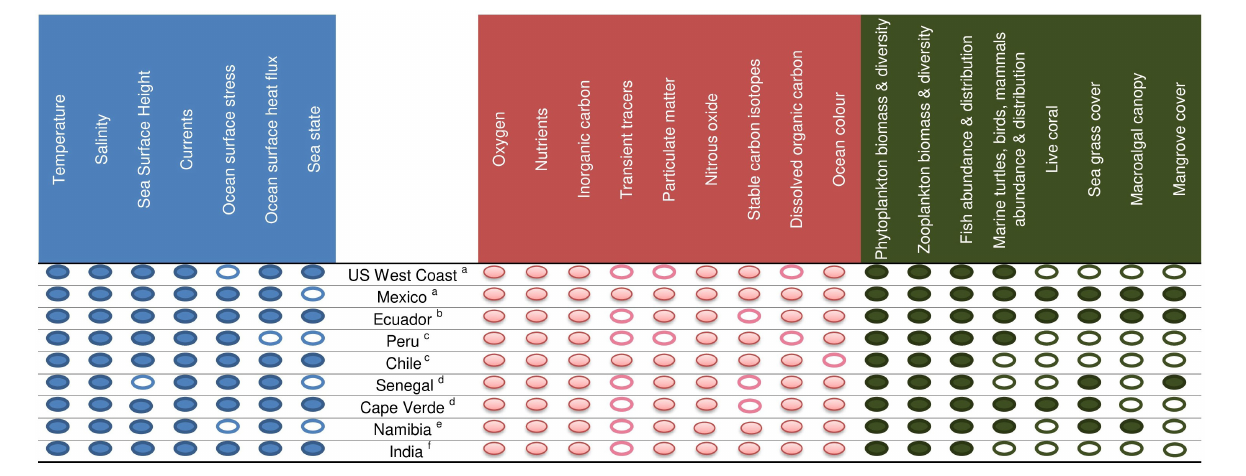
in national scientific journals. Examples include, for